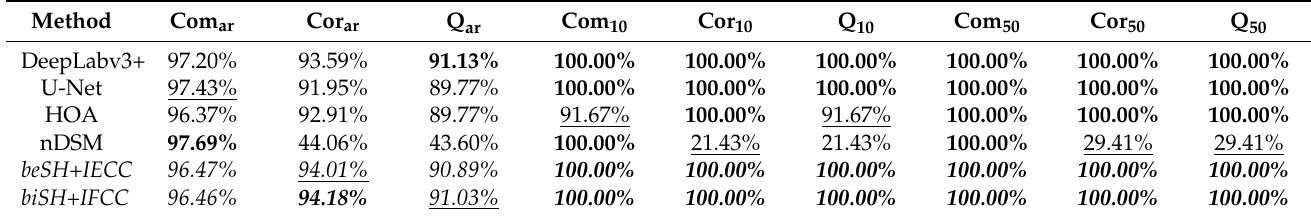
Table 2. Quantitative evaluation results of different methods on the second test